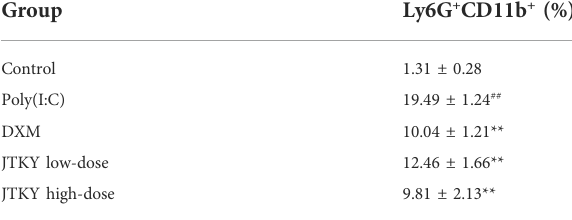
TABLE 2 Effects of JTKY on the proportions of CD86 + and CD206 + cells in BALF. Group